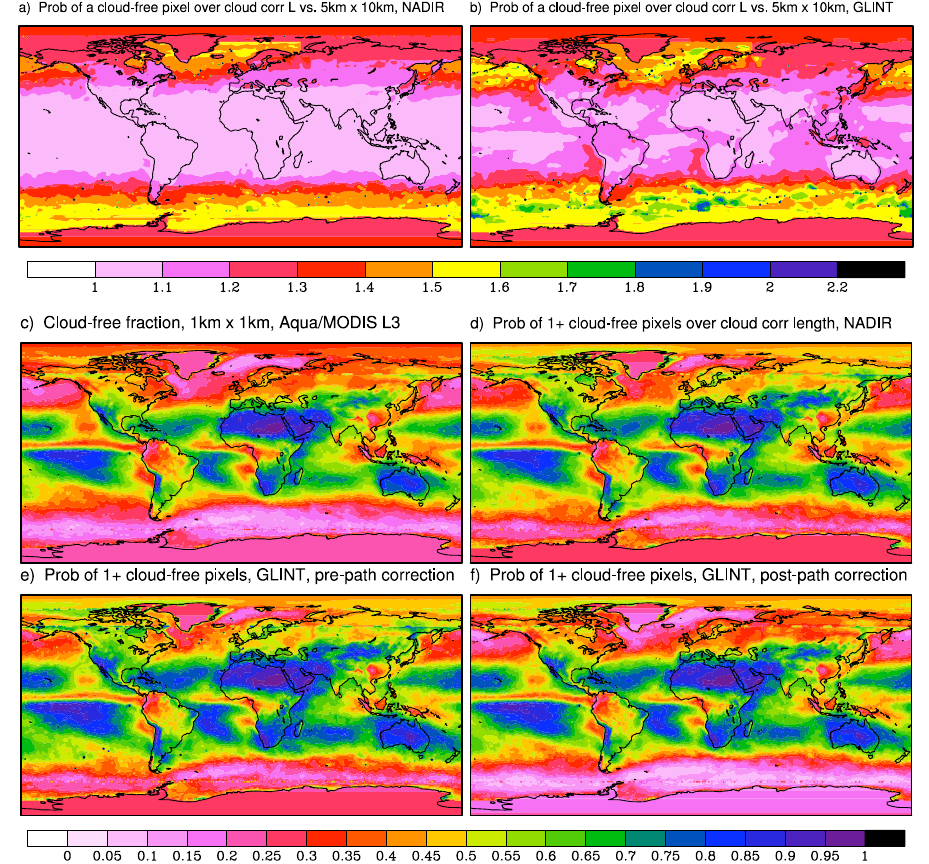
Fig. A1. Computation of climatological cloud-free pixel availability from Terra/MODIS and Aqua/MODIS data. The ratio of the probability of finding at least one cloud-free sounding across a ground track swath of length L (Fig. 5b) over the same probability for a swath only 5km long, calculated by sampling 10km-wide Terra/MODIS Level 2 data swaths in the along-track direction, using L for a) nadir- and (b) glint. (c) The cloud-free probability at 1km × 1km resolution, taken from the Aqua/MODIS Level 3 cloud-mask product. (d) and (e) : the probability of finding at least one cloud free sounding in an OCO ground track swath of length L (nadir and glint) found by multiplying (c) by (a) and (b). (f) The glint-mode cloud-free probability from (e) corrected for the greater atmospheric path length at high SZAs according to Eq. (3). Note that the probabilities in (e) are higher than in (d) because L is about two times longer in glint than nadir (Fig. 5b); because they are divided by L in Eq. (2), however, the resulting N eff values are lower in glint than nadir, even without the glint path